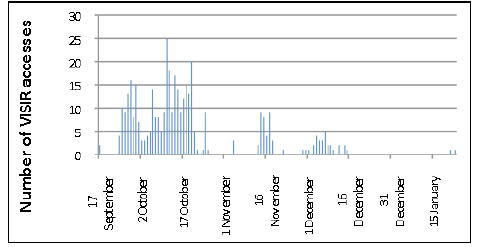
Figure 4. Course 5: VISIR direct accesses along the semester.